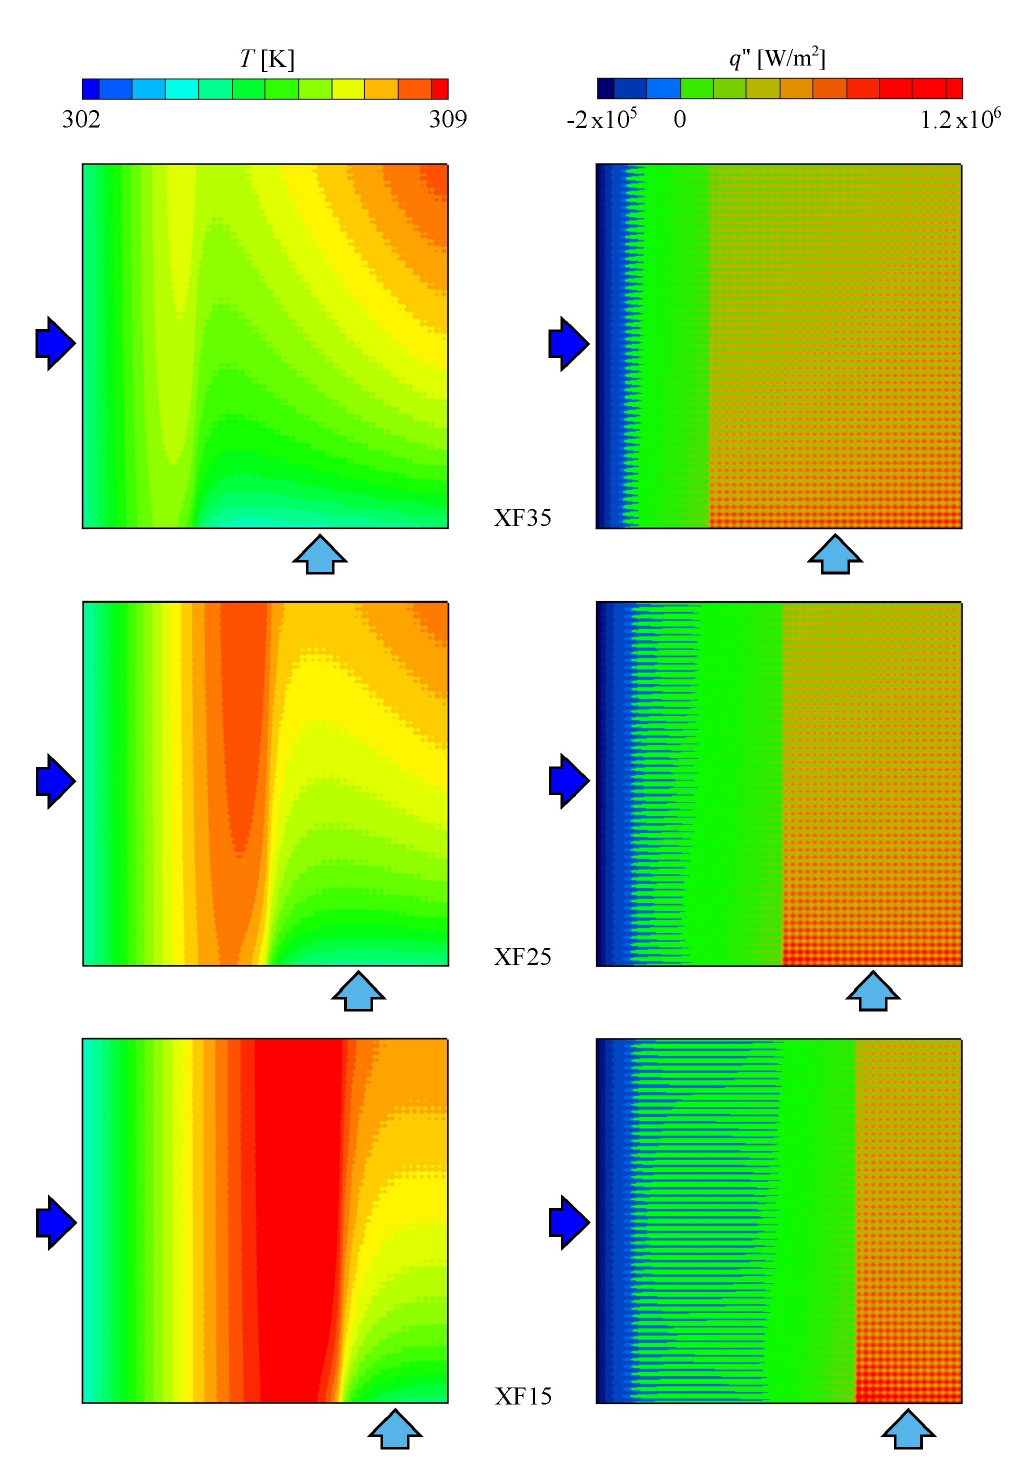
Figure 7. Temperature ( left ) and heat flux ( right ) distributions on the midplane between the bottom and the top layers in types XF15, XF25 and XF35 of DL-MCHSs for ˙ V = 5.0 mL/s (blue: negative heat flux; dark blue arrow: bottom layer; light blue arrow: top